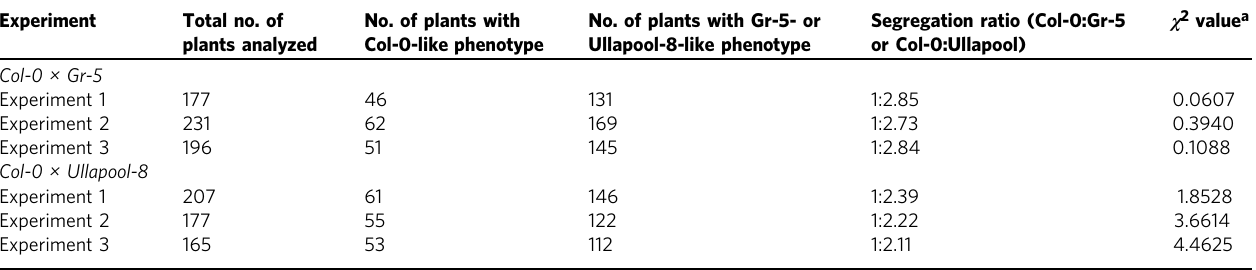
Table 1 Segregation ratios of the F2 progenies of Col-0 × Gr-5 and Col-0 × Ullapool-8 crosses.